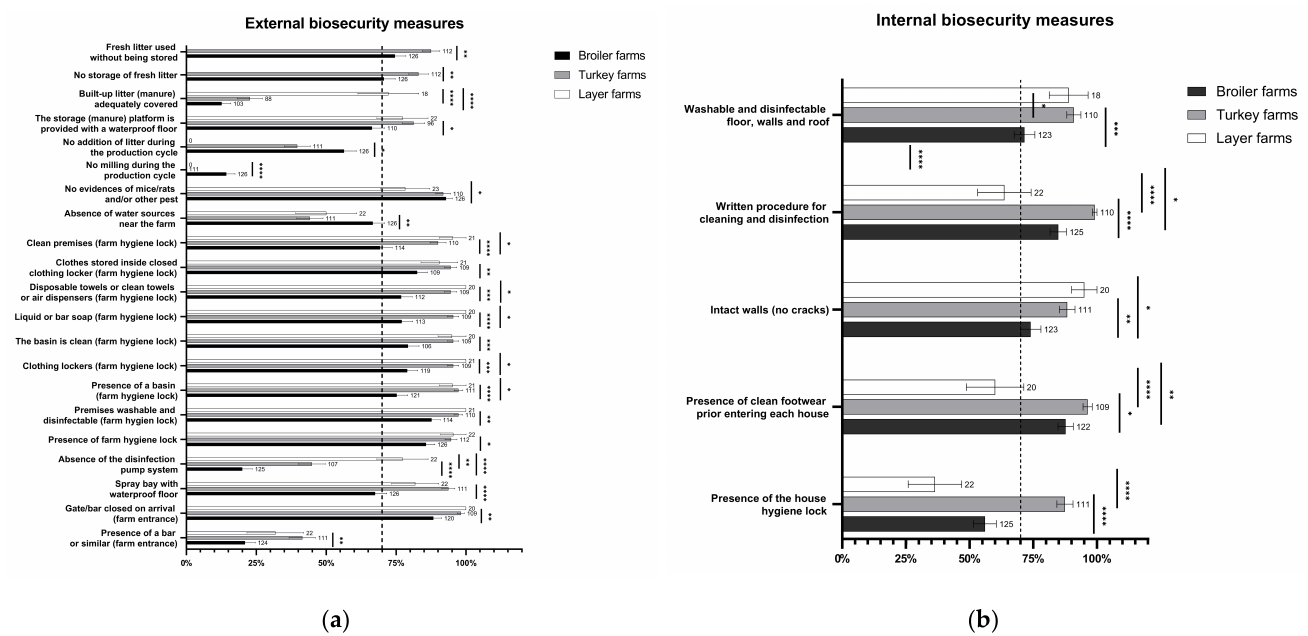
Figure 1. Level of significance among biosecurity measures in broiler, turkey, and layer farms. The